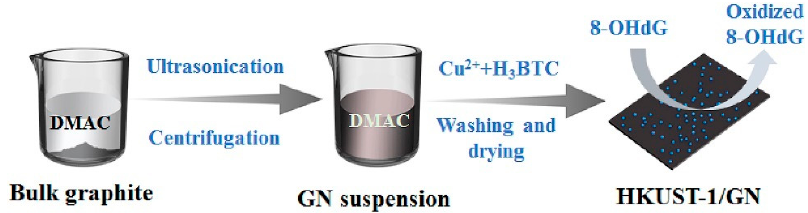
Figure 4. The schematic representation of metal organic framework nanoparticles for the measurement of o 8 dGuo. Reprinted with permission from Reference [32]. © 2019, Elsevier.